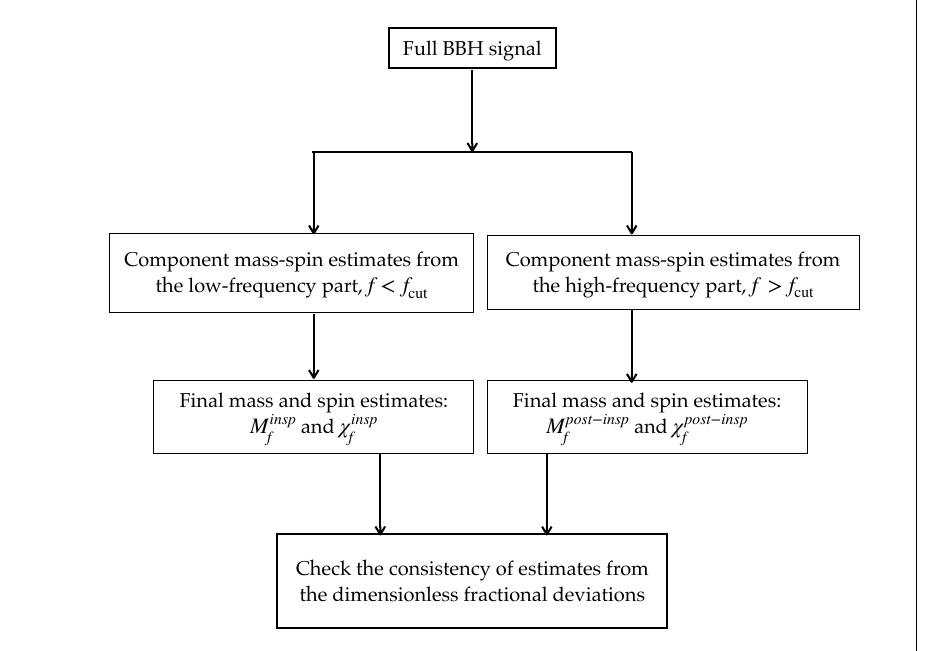
Figure 3. The figure shows the graphical demonstration of the inspiral-merger-ringdown consistency test. We start with the full BBH signal. Analyze the signal by restricting the noise-weighted integral in the likelihood calculation to frequencies below and above the cut-off frequency, f cut . From the two independent mass-spin estimates obtained above, the merger remnant properties are calculated by averaging NR-calibrated final state fits. If the data is consistent with GR, the deviation parameters defined in Equations (6) and (7) will be zero, assuming that the waveform model employed accurately models a BBH evolution in GR. See Reference [86] for more details and